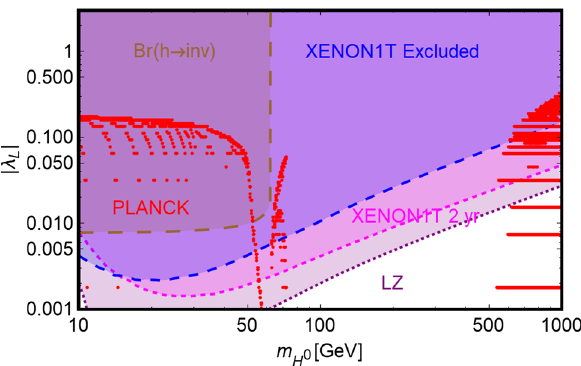
Fig. 24 Model points with the correct DM relic density (red points) obtained from a scan over the parameters of the IDM (see main text for details) in the bi-dimensional m H 0 , | λ L | plane. The blue, magenta and purpleregionsareexcludedbythecurrentboundsfromXENON1Tand, projected sensitivities by XENON1T and LZ, respectively. The brown region is excluded by the constraint on the invisible branching fraction of the SM Higgs